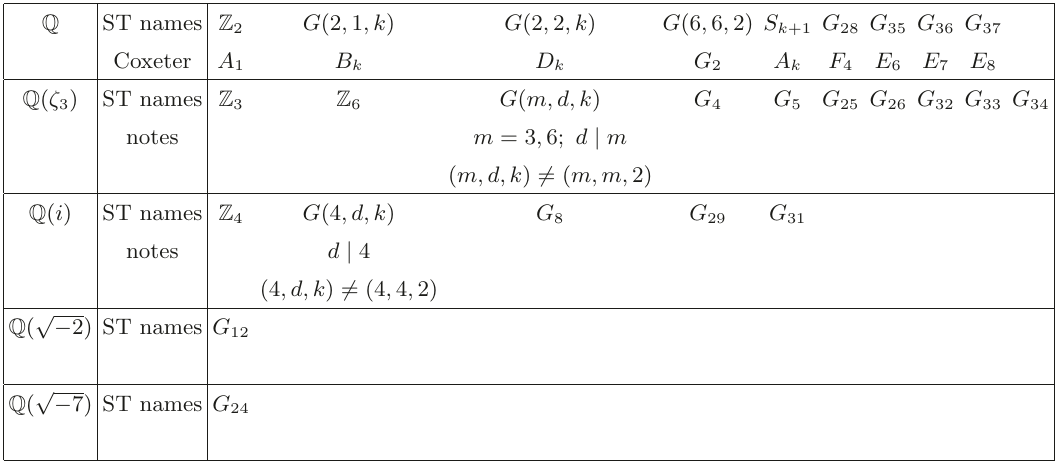
Weyl( A 2 ), G (6 , 6 , 2) Weyl( G 2 ), and G (4 , 4 , 2), ≡ ≡